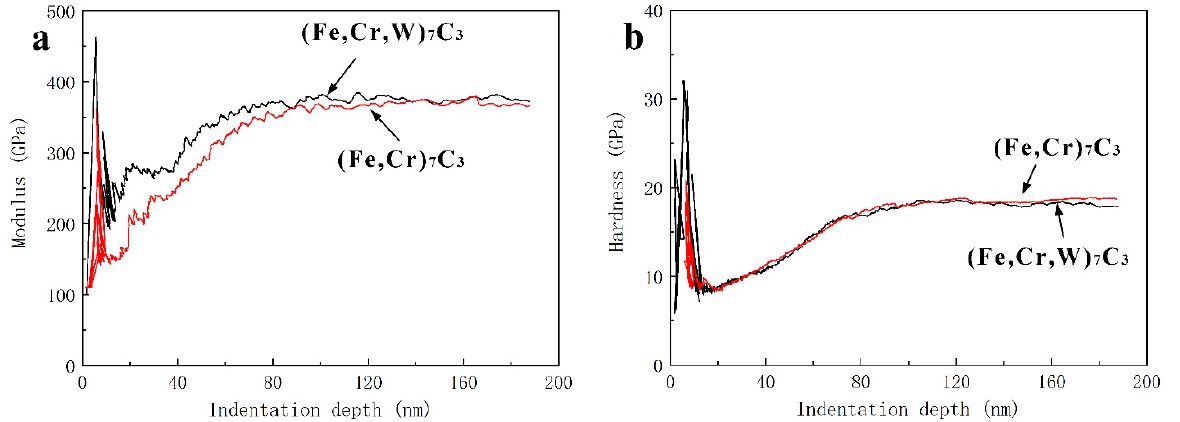
Figure 9. Indentation hardness and indentation modulus of M 7 C 3 phase: ( a ) indentation hardness; ( b ) indentation modulus.